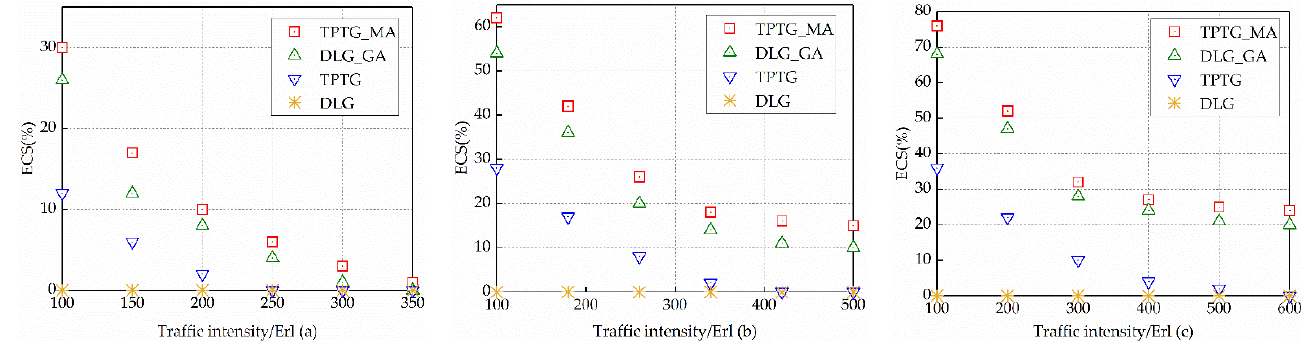
Figure 4. Comparisons of the ECS between the DLG, TPTG, DLG_GA, and TPTG_MA under ( a ) 6-node topology, ( b ) 12-node topology, and ( c ) 22-node topology.